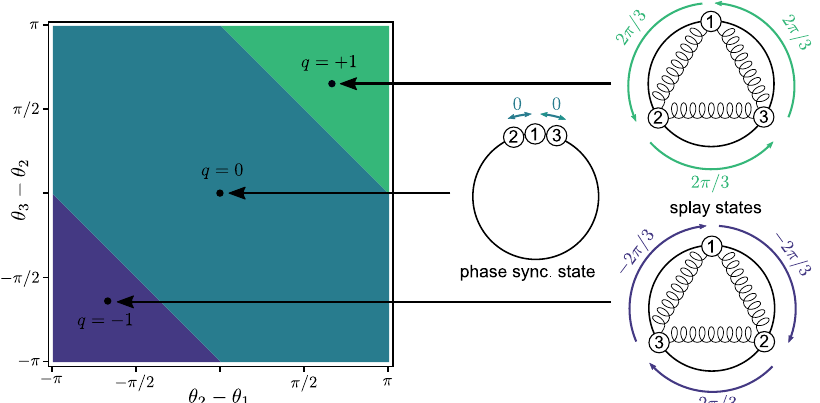
Fig. 1 | Winding cell partition and equilibria for a three-node spring network. Projected winding cell partition of the 3-torus (left) and representation of three equilibria of a spring network (right). Points on the 3-torus are projected on the two-dimensionalspaceofangulardifferences θ 2 − θ 1 and θ 3 − θ 2 .Awindingnumber q 2 Z is associated to each equilibrium, counting the number of times its angles wind counterclockwise around the origin.The three dots (left) areequilibria of the